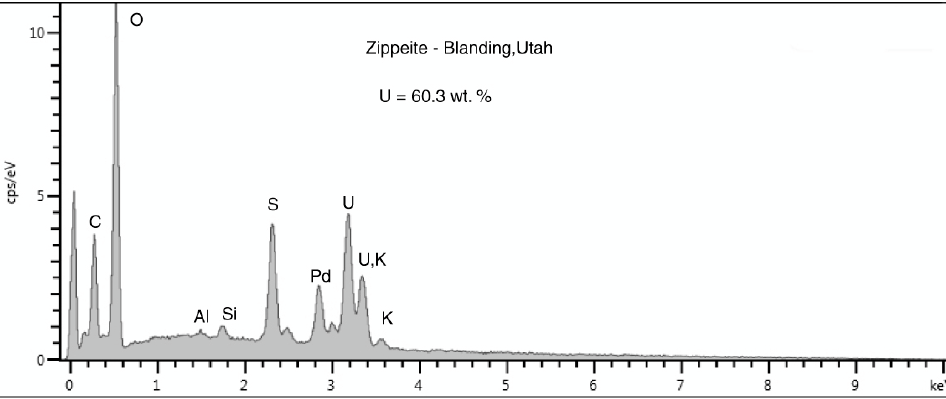
Figure 12. SEM/EDS spectrum of microcrystals shown in Figure 11B. The Pd peak is caused by the metal layer applied to the specimen surface to provide electrical conductivity. The peak at 0KeV is detector noise related to the low count rate. The peak at 3.3KeV is a combination of the M orbital peak for uranium and the K α peak for potassium. The presence of the latter element can be confirmed by the smaller K β peak at 3.59 KeV.